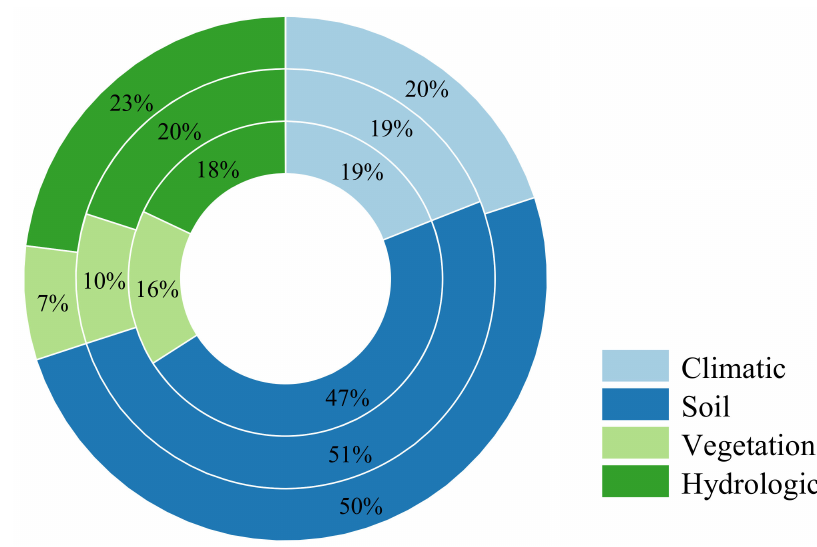
Figure 6. The ring weight graph of the evaluation factors in the sub criteria layer.